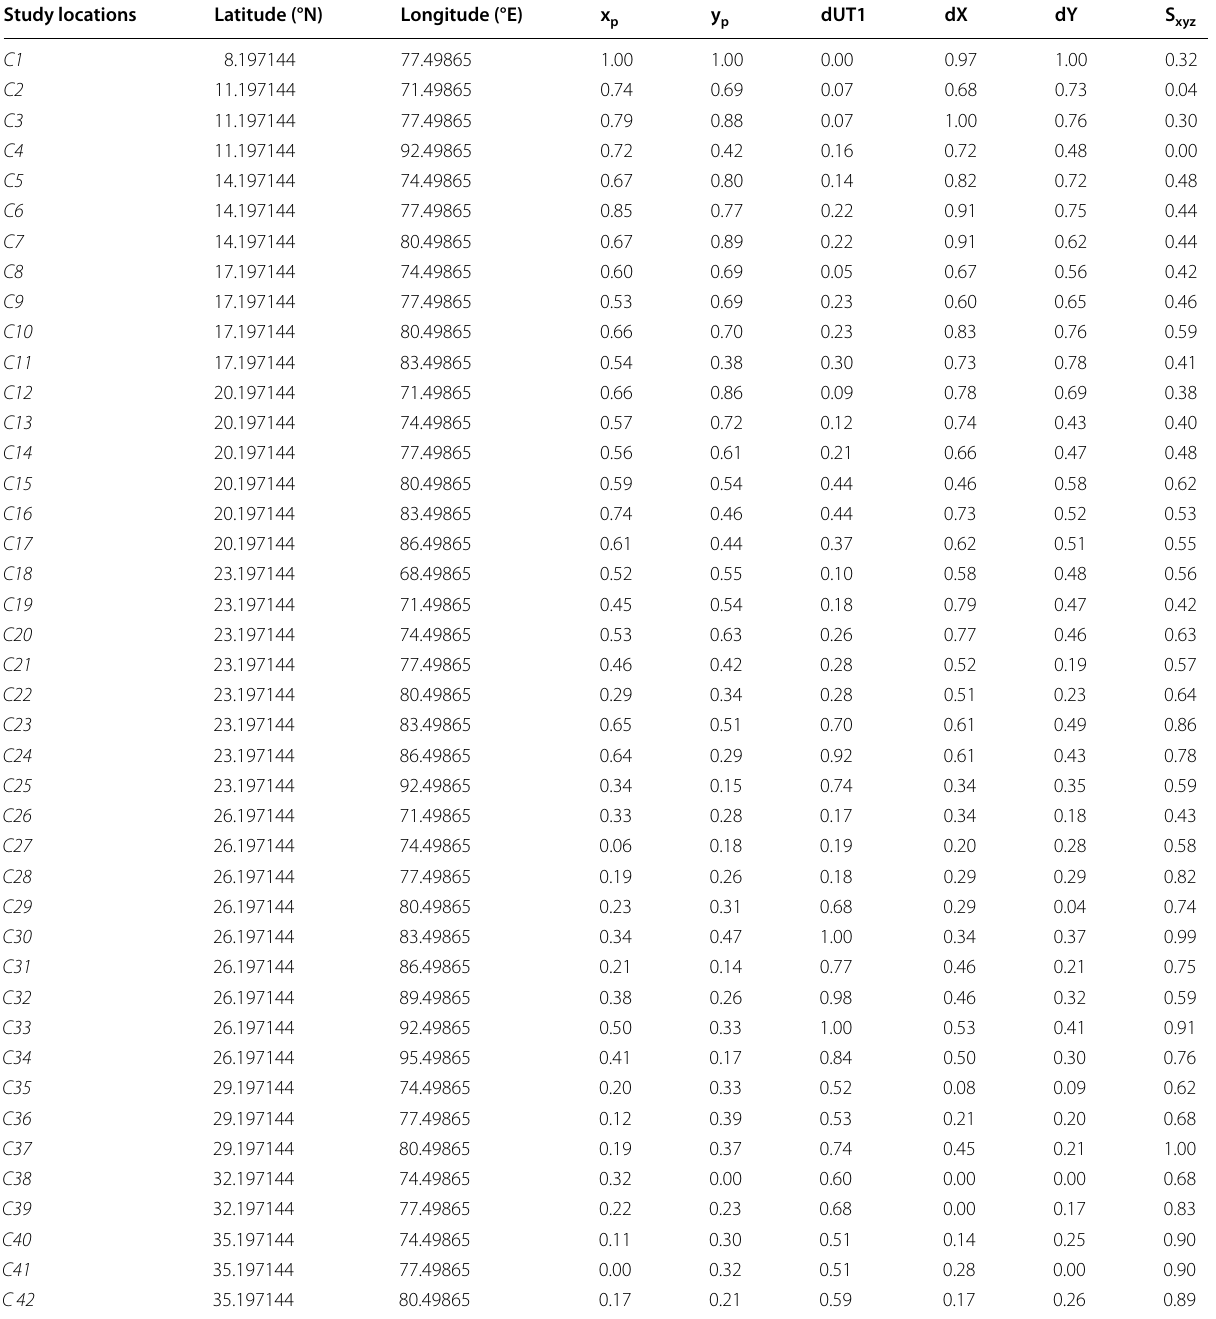
Table 9 Cumulative rescaled values of improvement percentage of each geodetic parameter in this study Study